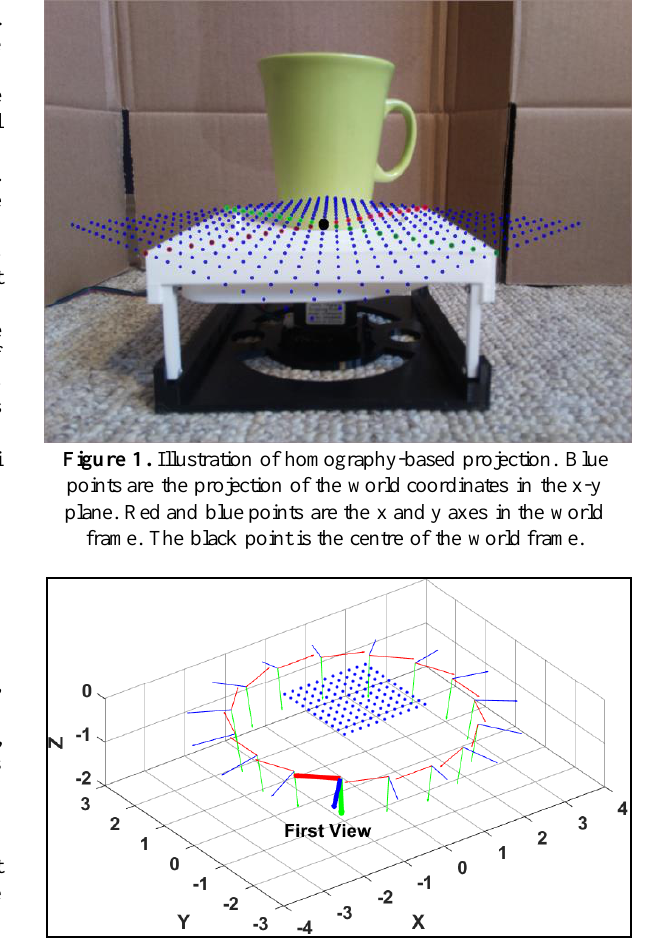
Figure 2. Sixteen camera poses are shown in the world frame. First-view corresponds to the image in Figure